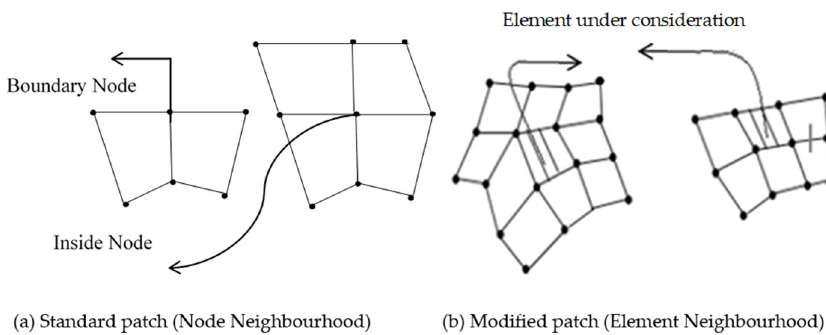
Figure 1. Patch configuration in triangular mesh.